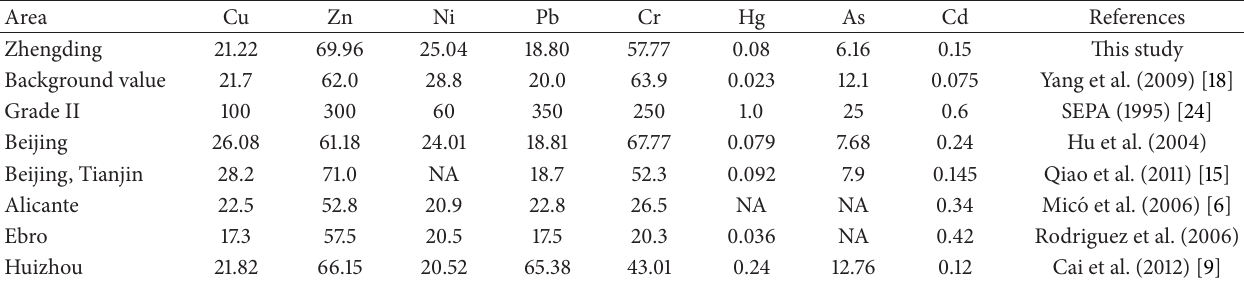
Table 2: A summary of heavy metal concentrations in agricultural soil for various areas